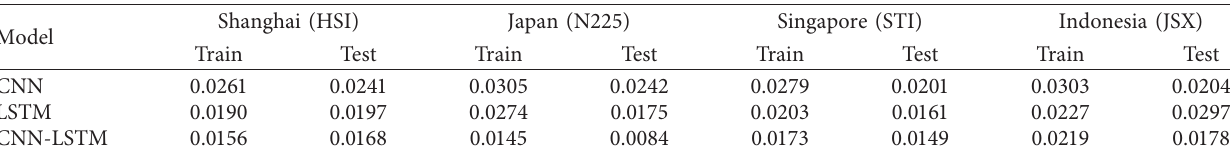
Table 4: Comparison of descriptive statistics between actual and predicted time-series data produced by the proposed multivariate CNN- LSTM model in testing period, i.e., last 72 trading days of 2020. Note: Act � actual and Pred � predictions. Descriptive